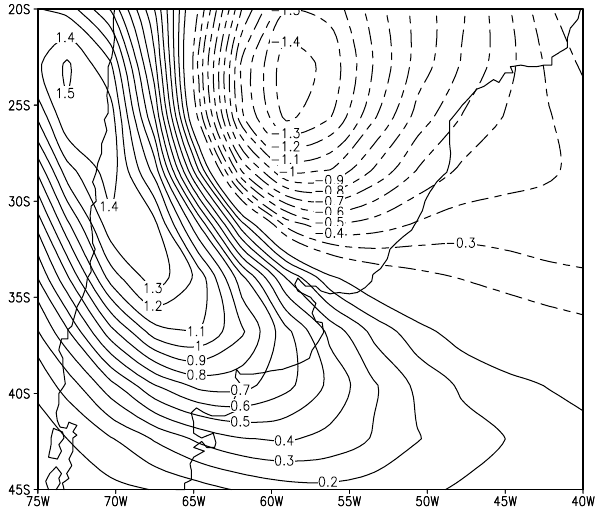
Figure 6 : Stream function anomalies (1x10-6 m 2 s -1 ) at 250 hPa (a) and 850 hPa (b), on day 10 of Fig. 6. Stream function anomalies (1 × 10 − 6 m 2 s − 1 ) at 250hPa (a) and 850hPa (b) , on day 10 of integration, corresponding to − σ basic state experiment with the forcing at 120 ◦ E–15 ◦ S (see dot in the figure). integration, corresponding to - σ basic state experiment with the forcing at 120ºE-15ºS (see gray dot in the figure)